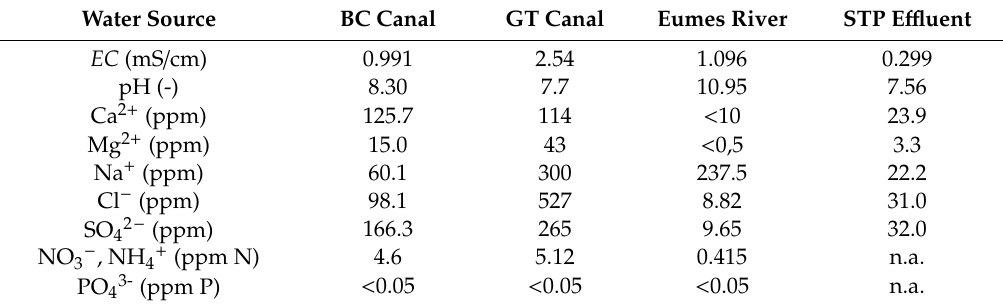
Table 5. Chemical composition of cooling water